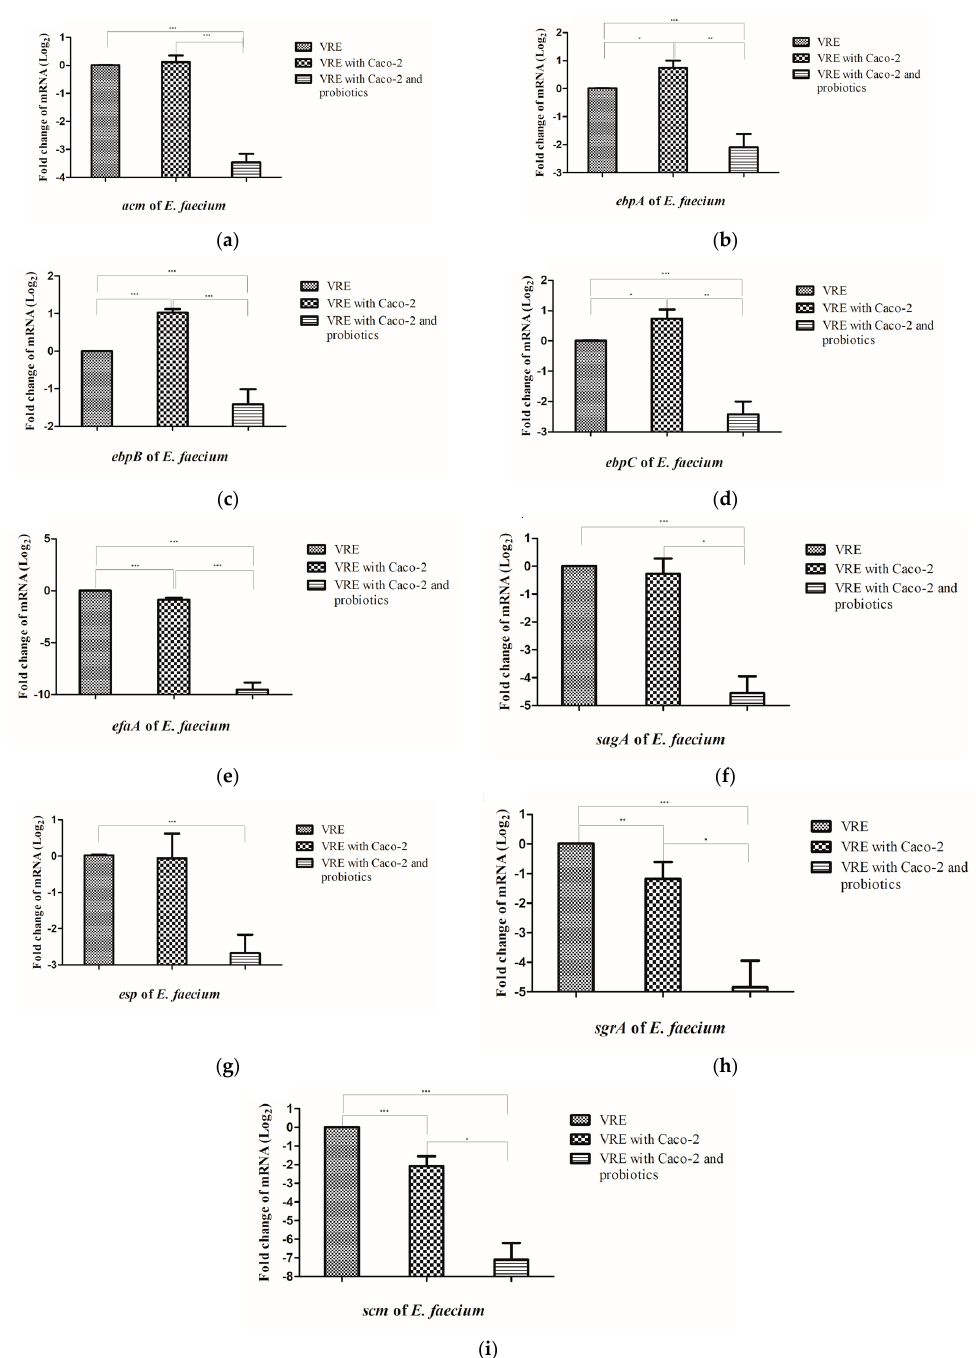
Figure 4. Probiotic combination reduced the expression of VRE E. faecium virulence genes when co-incubated with Caco-2 cells. The mRNA expression levels of E. faecium virulence genes: ( a ) acm , ( b ) ebpA , ( c ) ebpB , ( d ) ebpC , ( e ) efaA , ( f ) sagA , ( g ) esp , ( h ) sgrA , and ( i ) scm were evaluated after incubation in serum-free Dulbecco’s modified Eagle‘s minimal essential medium (DMEM) alone (VRE), with Caco-2 cells (VRE and Caco-2), and with Caco-2 cells and probiotics (VRE with Caco-2 and probiotics) at 37 °C under 5% CO 2 for 2.5 h. The experiments were independently performed in triplicate. p < 0.05, < 0.01, and < 0.001 indicated statistically significant, highly significant, and extremely significant differences, respectively and depicted as * p < 0.05, ** p < 0.01, and *** p < 0.001 in figures.